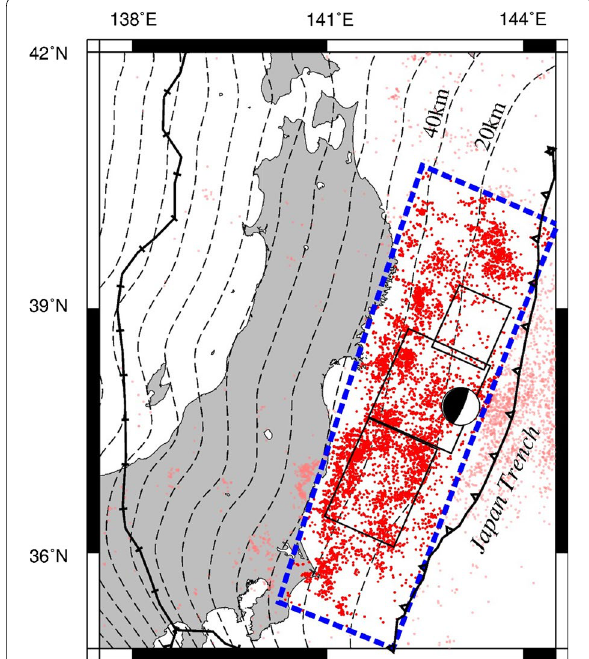
between March 11, 2011, and December 31, 2017, with focal depths shallower than 100 km and magnitudes larger than 4.0. We estimate the parameters of the aftershock decay (in the modified Omori law) from the earthquakes of the red points located within the blue dotted quadrangle. The pale red points represent earthquakes located out of the quadrangle